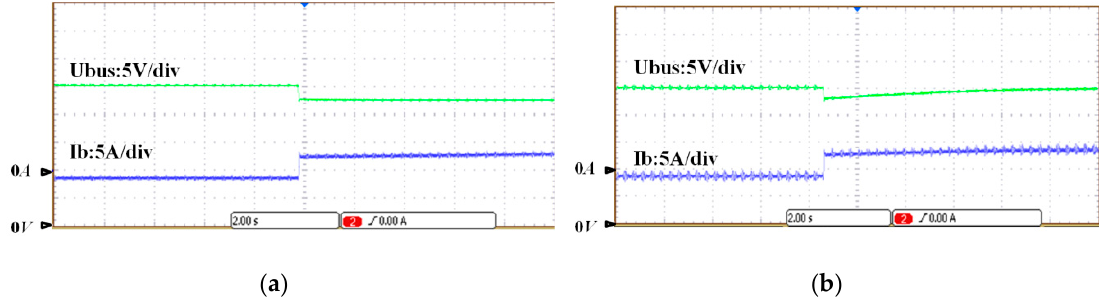
Figure 9. Experimental results of power of CPL stepping from 20W to 100W: ( a ) The #1 experimental results of DC bus voltage, load current and battery current; ( b ) The #2 experimental results of DC bus voltage, load current and battery current.